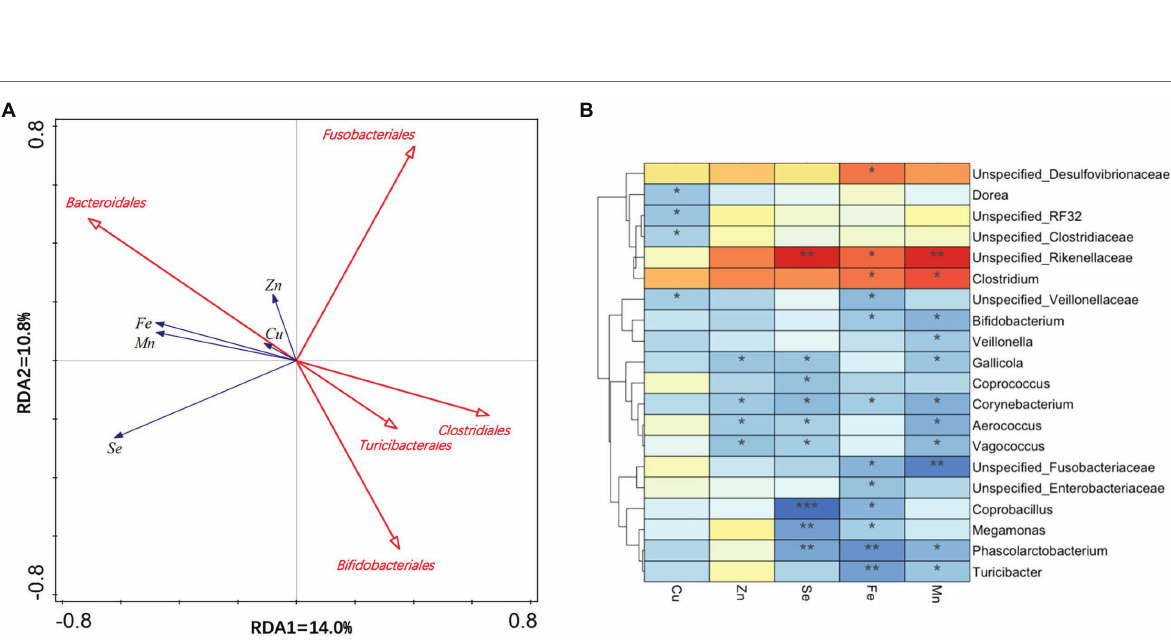
FIGURE 4 | Correlation between fecal metal concentration and gut microbiota at order level. (A) Redundancy analysis (RDA) plot showed significant ( p < 0.05) relationships between environmental variables (fecal metal concentration) and cecal bacterial communities. (B) Spearman’s heatmap correlation on order combined with UPGMA cluster analysis between abundance of series of to 25 bacteria order and environmental parameters. Negative correlation and positive correlation were represented by blue color and red color. *0.01 < p ≤ 0.05, **0.001 < p ≤ 0.01, and *** p ≤